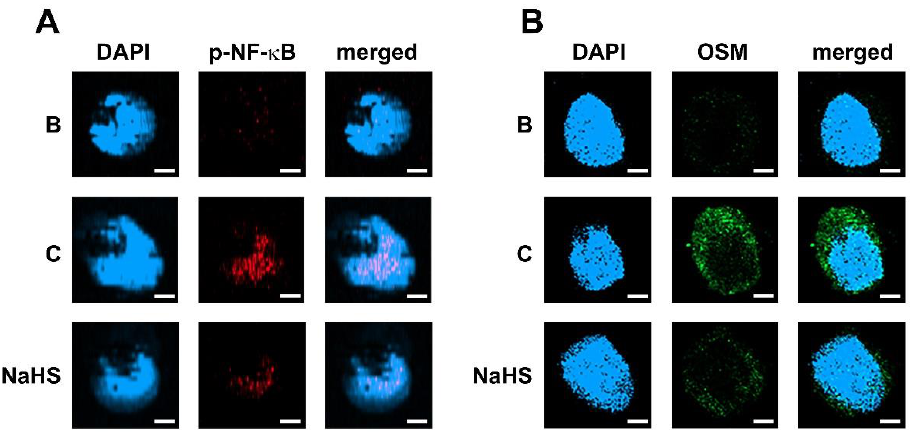
Figure 6. Inhibition of p-NF- κ B and OSM immunofluorescence staining by NaHS in dHL-60 cells. ( A ) Cells (1 × 10 6 /mL) were pretreated with NaHS (1 mM) for 1 h, followed by GM-CSF stimulation (5 ng/mL) for 30 min; fluorescence microscope images stained with anti-p-p65 antibodies. ( B ) Cells (1 × 10 6 /mL) were pretreated with NaHS (1 mM) for 1 h, followed by GM-CSF stimulation (5 ng/mL) for 3 h; fluorescence microscope images stained with anti-OSM antibodies. Blank (B) corresponds to PBS treated cells without GM-CSF stimulation, and control (C) corresponds to PBS treated cells stimulated by GM-CSF. Representative images were obtained from images performed in triplicate (scale bar = 20 μ m).